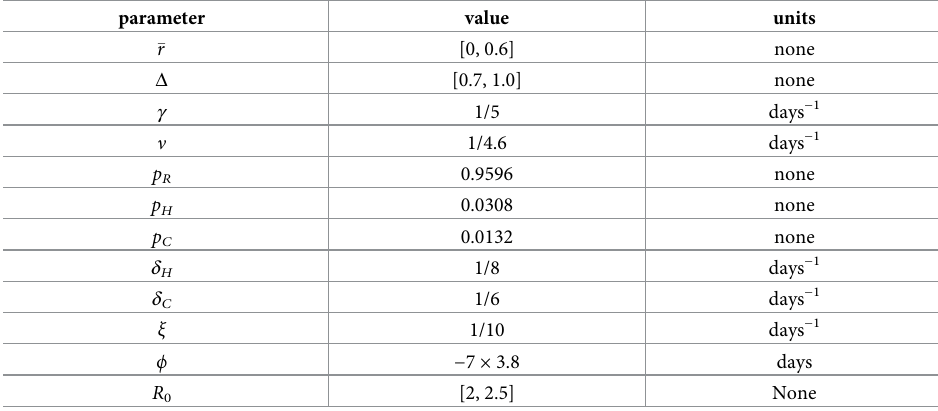
Table 1. Parameter ranges for the compartmental model for COVID-19 proposed in